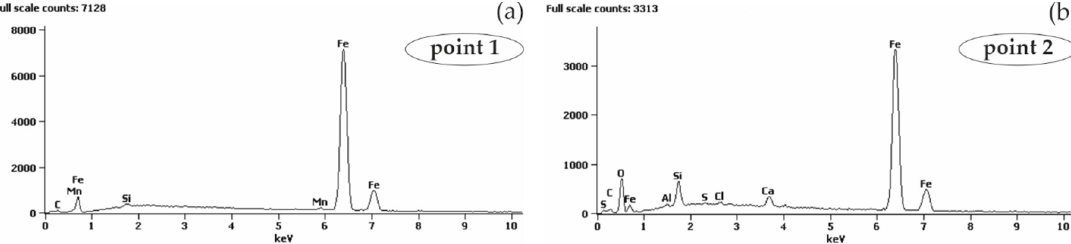
Figure 12. Spectra obtained from energy-dispersive X-ray spectroscopy (EDS) method for areas marked in Figure 11b: ( a ) from point 1 ( b ) from point 2